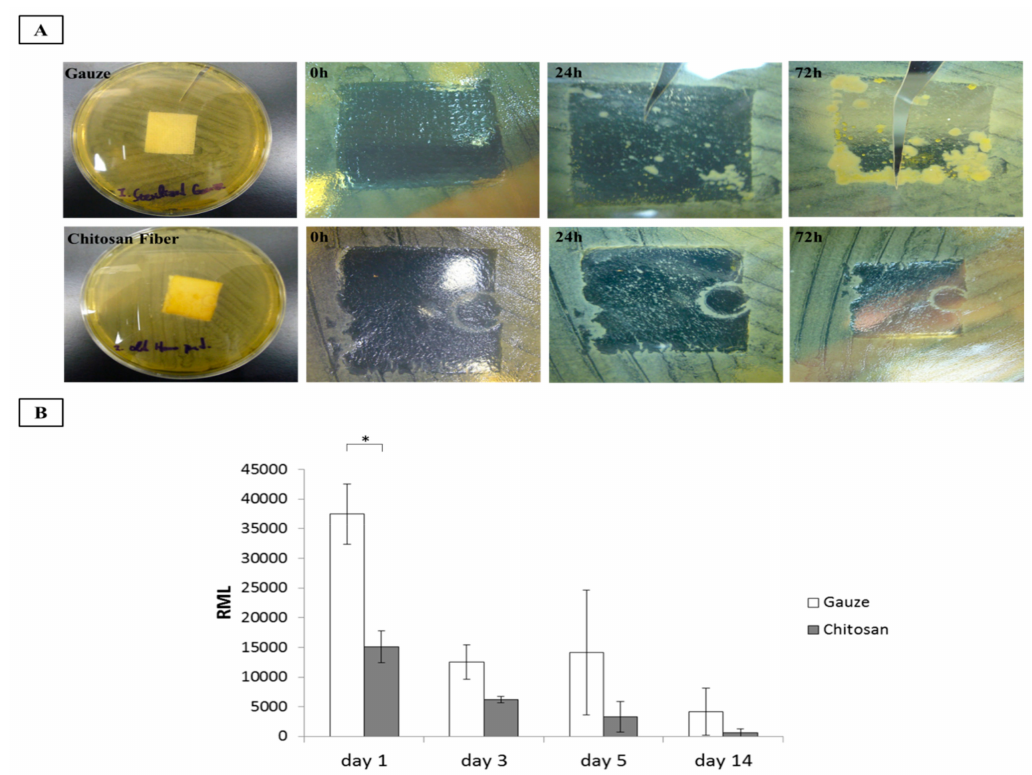
Figure 6. Antimicrobial activity evaluation. ( A ) In vitro . ( B ) Adenosine triphosphate (ATP) assay of microbial proliferation in patients with surgical wounds, *p <